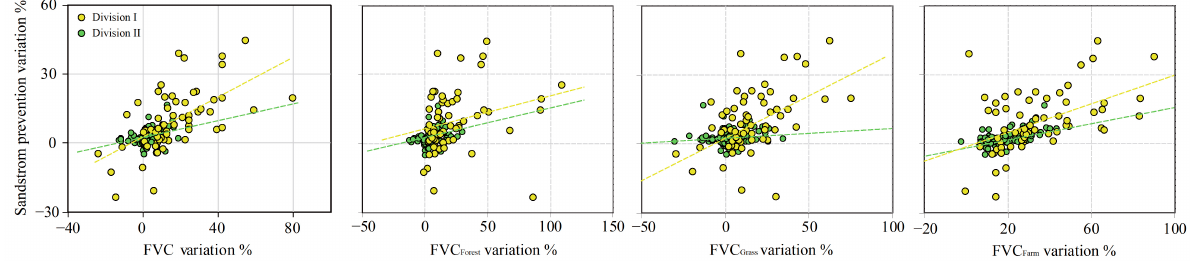
Figure 5. The correlation between the variation in wind erosion prevention services (WEPSs) and variation in various FVCs at the municipal scale. FVC: Fractional vegetation coverage; FVC Forest : Fractional vegetation coverage of forest; FVC Grass : Fractional vegetation coverage of grassland; FVC Farm : Fractional vegetation coverage of farmland.